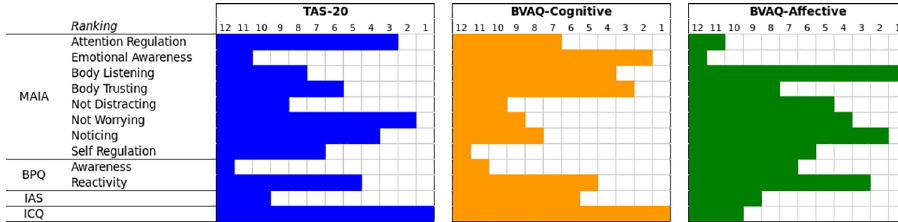
Fig 1. Ranking of ML predictors for each target variable (TAS-20, BVAQ-Cognitive, BVAQ-Affective), derived from the coefficients of the linear SVM model. The ranking ranges from 1 (best predictor) to 12 (worst